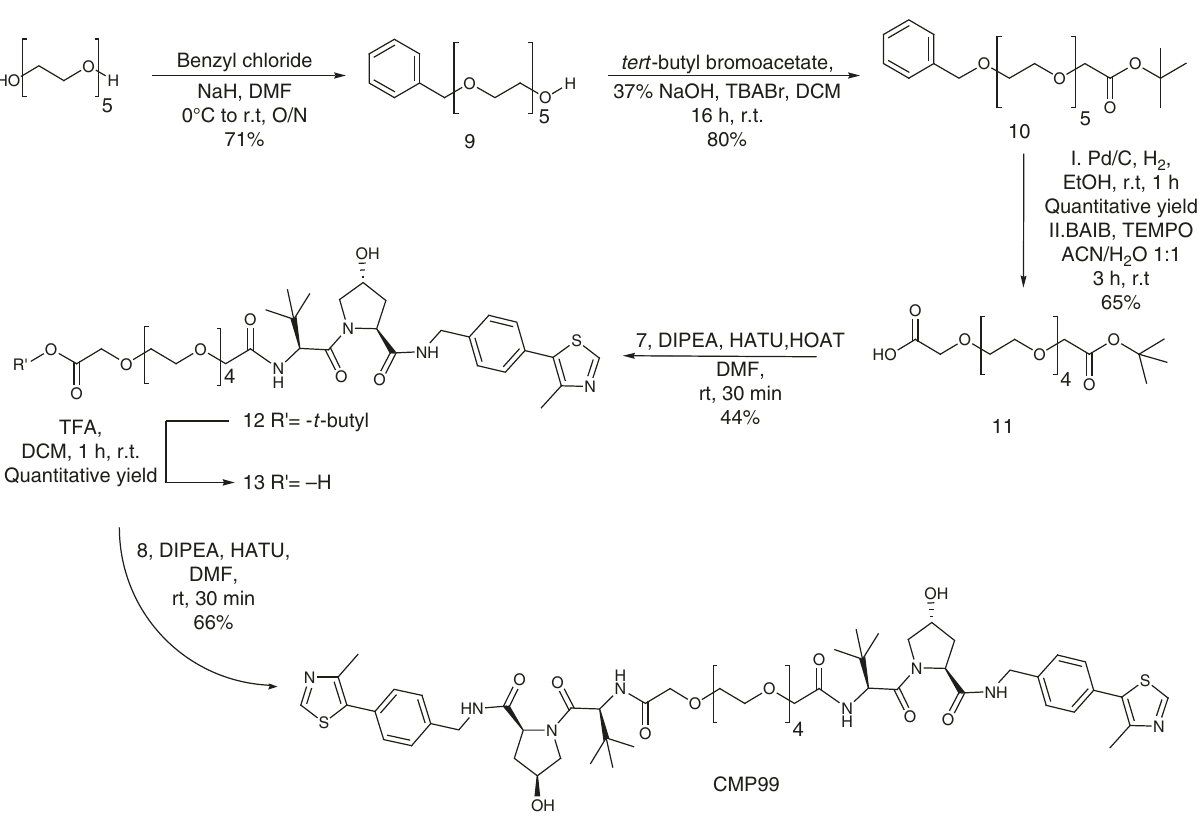
Fig. 3 Synthesis of negative control homo-PROTAC compound derivatized from the terminal acetyl group. Compound CMP99 has cis-trans con fi